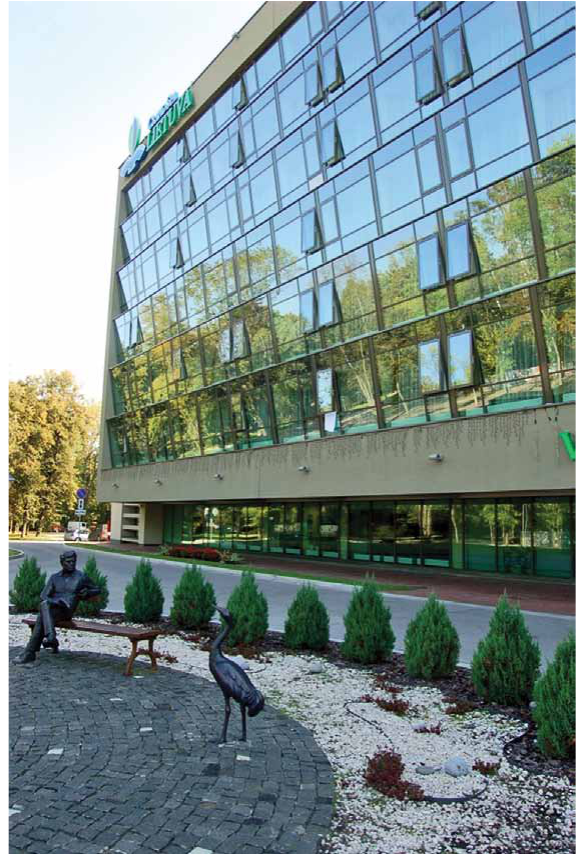
fig. 10. Druskininkai “Grand SPa lietuva” health and relaxation centre: the example of the innovative modernization of the urban complex in lithuania